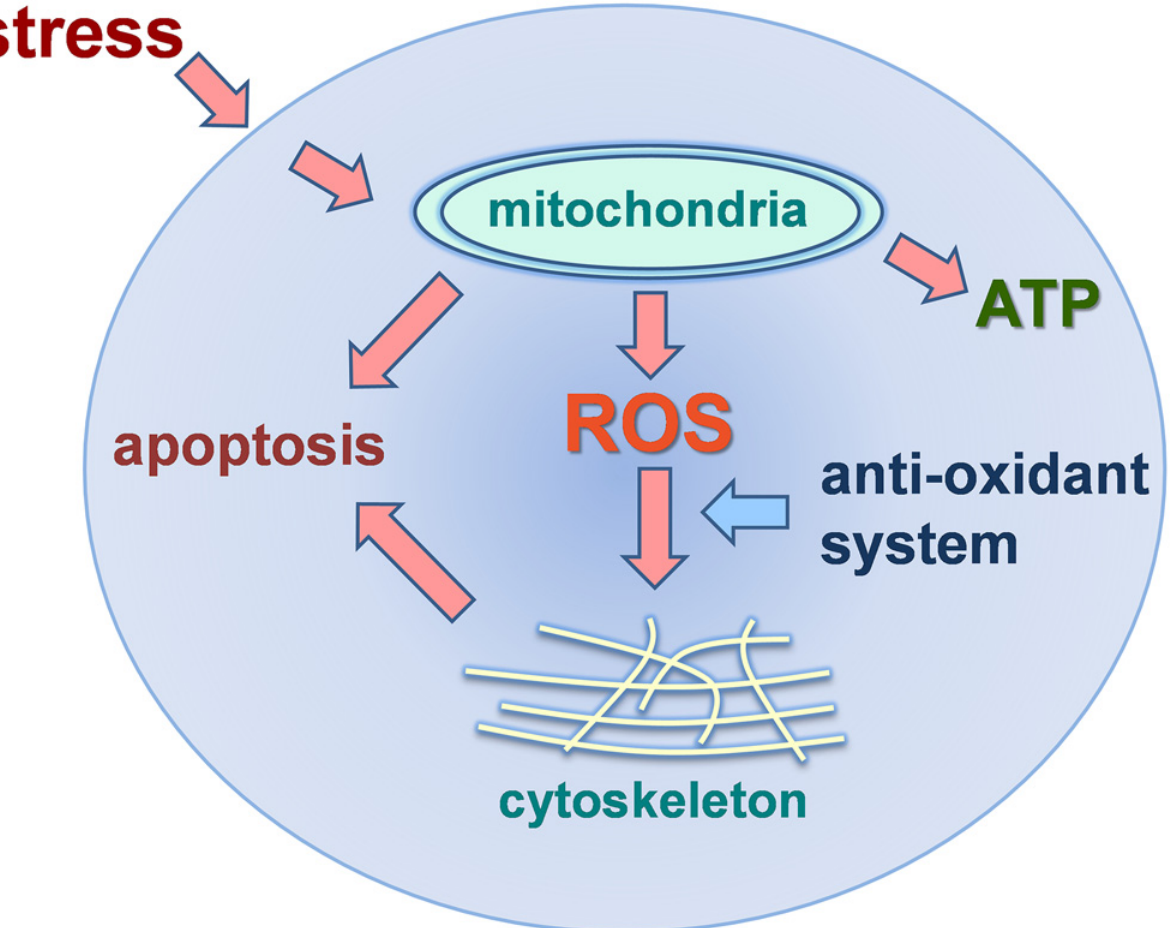
Fig 7. A consensus model of intracellular responses to stress in oysters based on the genes and/or biological processes that were found in our analysis to be differentially regulated in response to environmental stress. In this model, adaptive intracellular responses to stress lead to increased energy production (ATP) via the mitochondrial electron transport chain. Reactive oxygen species (ROS) are produced as by-products of ATP synthesis. Unless controlled by molecular chaperones (HSPs) and the anti-oxidant system, excessive ROS can disrupt the actin cytoskeleton and mitochondrial membranes leading to apoptotic cell